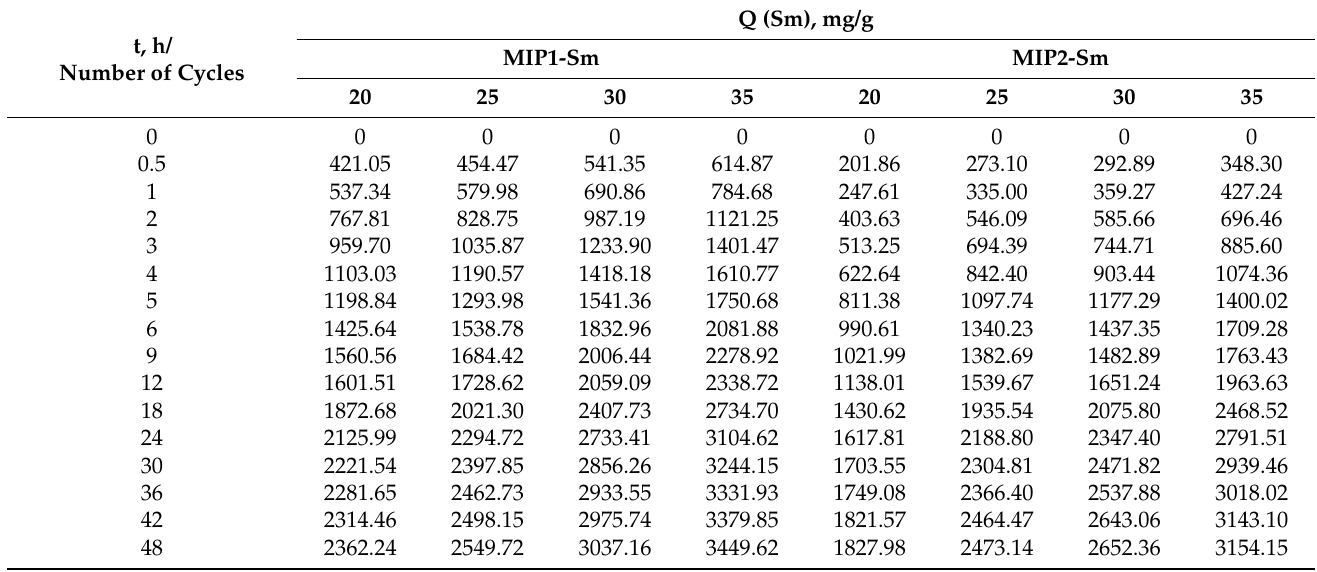
Table 5. Values of exchange capacity (in relation to samarium) after certain amount of template removal